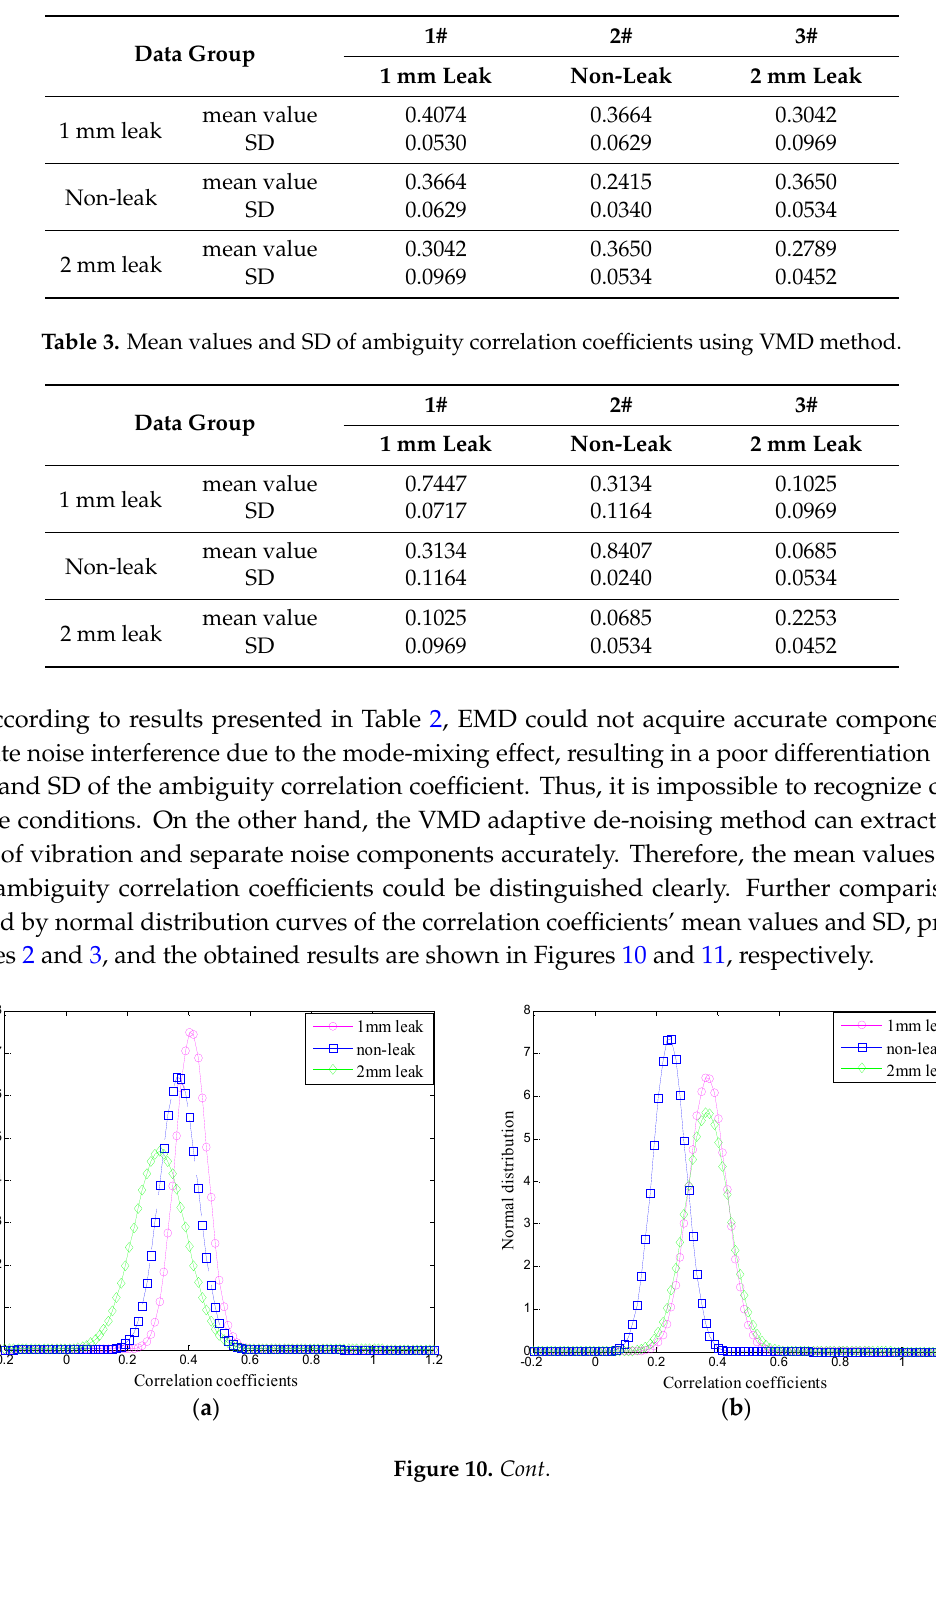
Table 2. Mean values and SD of ambiguity correlation coefficients using EMD method.